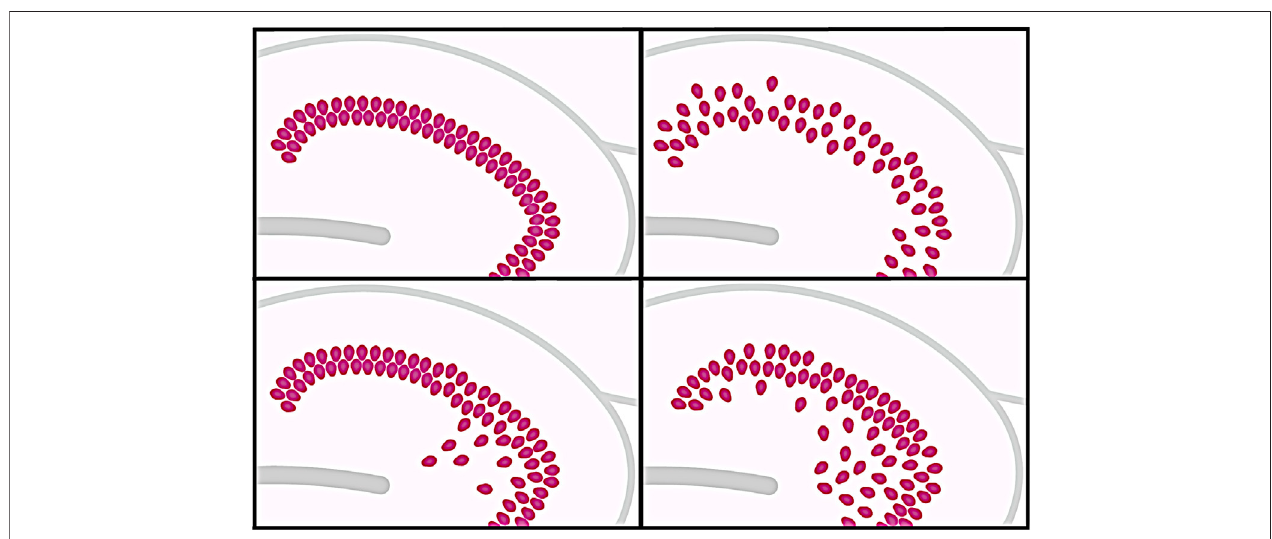
FIGURE2| Differentpatternsofgranulecelldispersion(GCD).ThedifferentpossiblepatternsofGCDareillustrated.Agranulecelllayer(GCL)considerednormalin the classical sense represents a compact band of cells with a relatively high cell density and is clearly delineated against the molecular layer (ML) (top left). In the disaggregated form of GCD, the GCL appears less densely packed and the boundary against the ML is blurred (top right). Ectopic granule cells, some of which can be found deep within the hilar region (bottom left), are shown in comparison to developmental GCD (bottom right), in which young differentiatedGCsmigrate from the hilar region to the GCL to ultimately build a compact